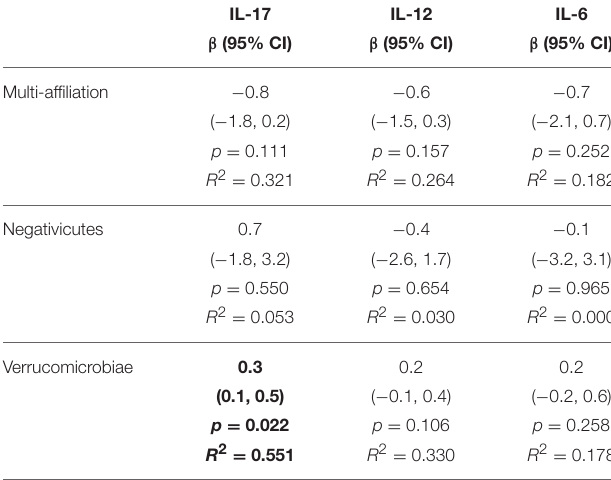
In each of the models, the associations are reported as absolute difference ( β ), with 95% Confidence Intervals (CI), in immune system parameters levels by 1 unit increase in gut microbiota. In bold are reported the statistically significant results (p < 0.05). Per each of the models, the Coefficient of determination (R 2 ) is also